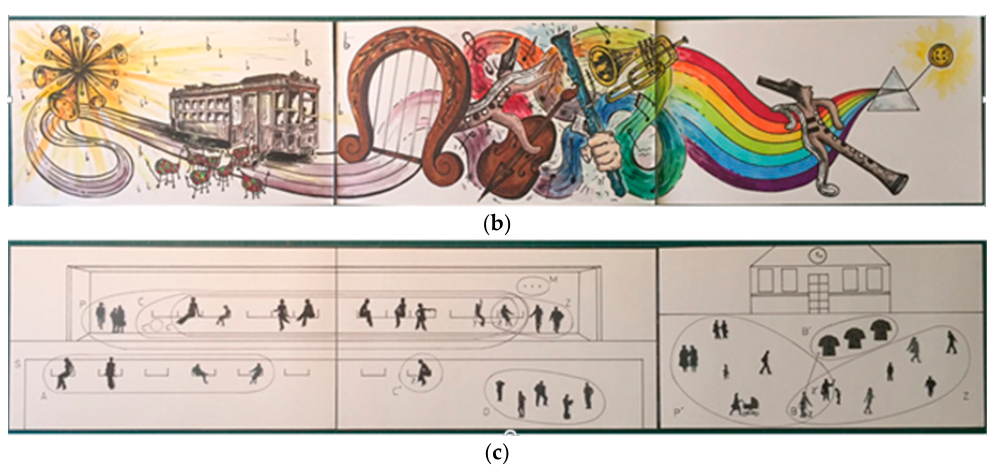
Figure 4. Exercises in Style, texticule: ( a ) Abusive , ( b ) Auditory, ( c ) Mathematical developed in the Visual Design class 2016–2017 by student Katarzyna Szolcznska, Roberta Mazzaferro and Serena Borgonovo.